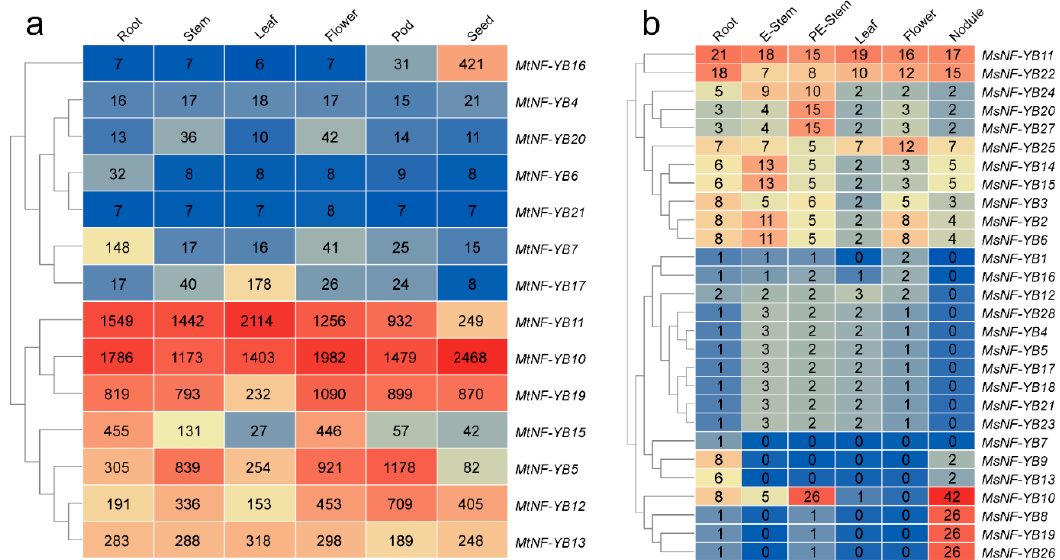
Figure 6. Expression profiles of NF-YB genes in different tissues of Medicago . ( a ) Expression profiles with the log2(FPKM) values of MtNF-YB genes in different tissues retrieved from the genechip dataset. ( b ) Expression profiles with the log2 (FPKM) values of MsNF-YB genes in different tissues retrieved from transcriptome data. Red represents high expression and blue represents low expression.